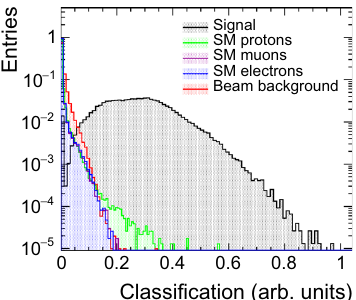
Fig. 13 AEclassificationdistributionforsignalanddifferentSM(stan- dard model)